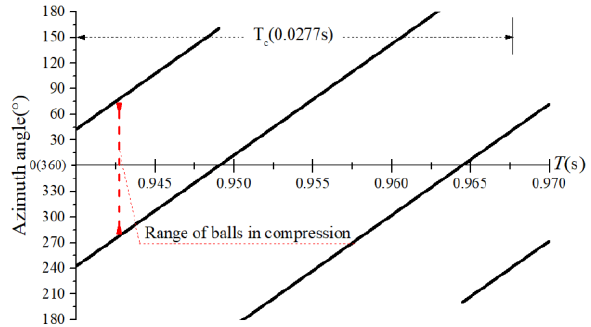
f = 100 N). ce f = 100 N). ce